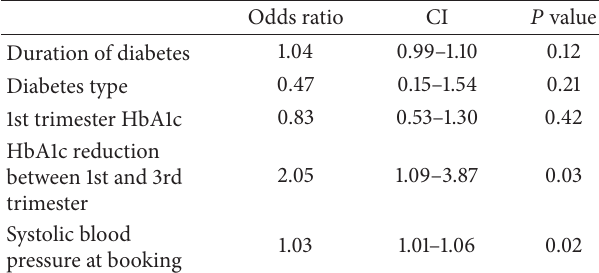
Table 5: Factors associated with retinopathy